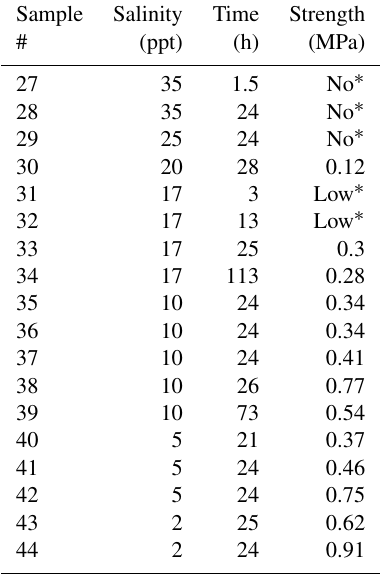
Table 2. Results from testing saline bond experiments at − 10 ◦ C and 35ppt.